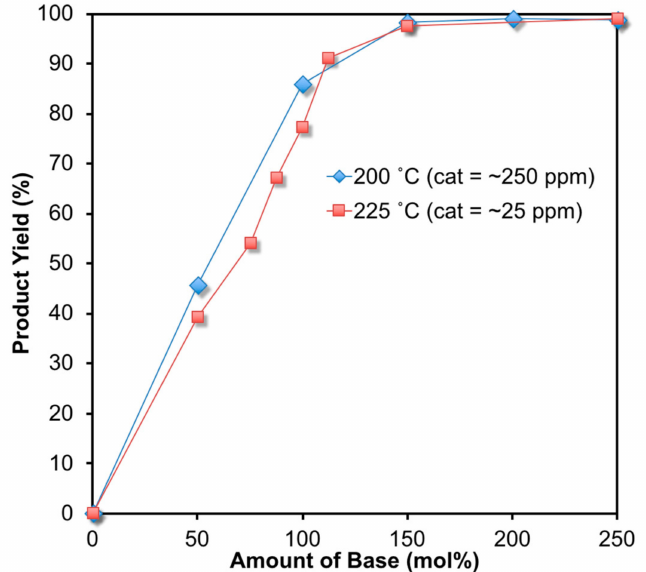
Figure 3. The effect of amount of base on yields of 3 in SMCs; (cid:4) : the yield of 3 at 225 ◦ C with 0.025 mol % of PdCl 2 , (cid:7) : the yield of 3 at 200 ◦ C with 0.25 mol % of PdCl 2 .